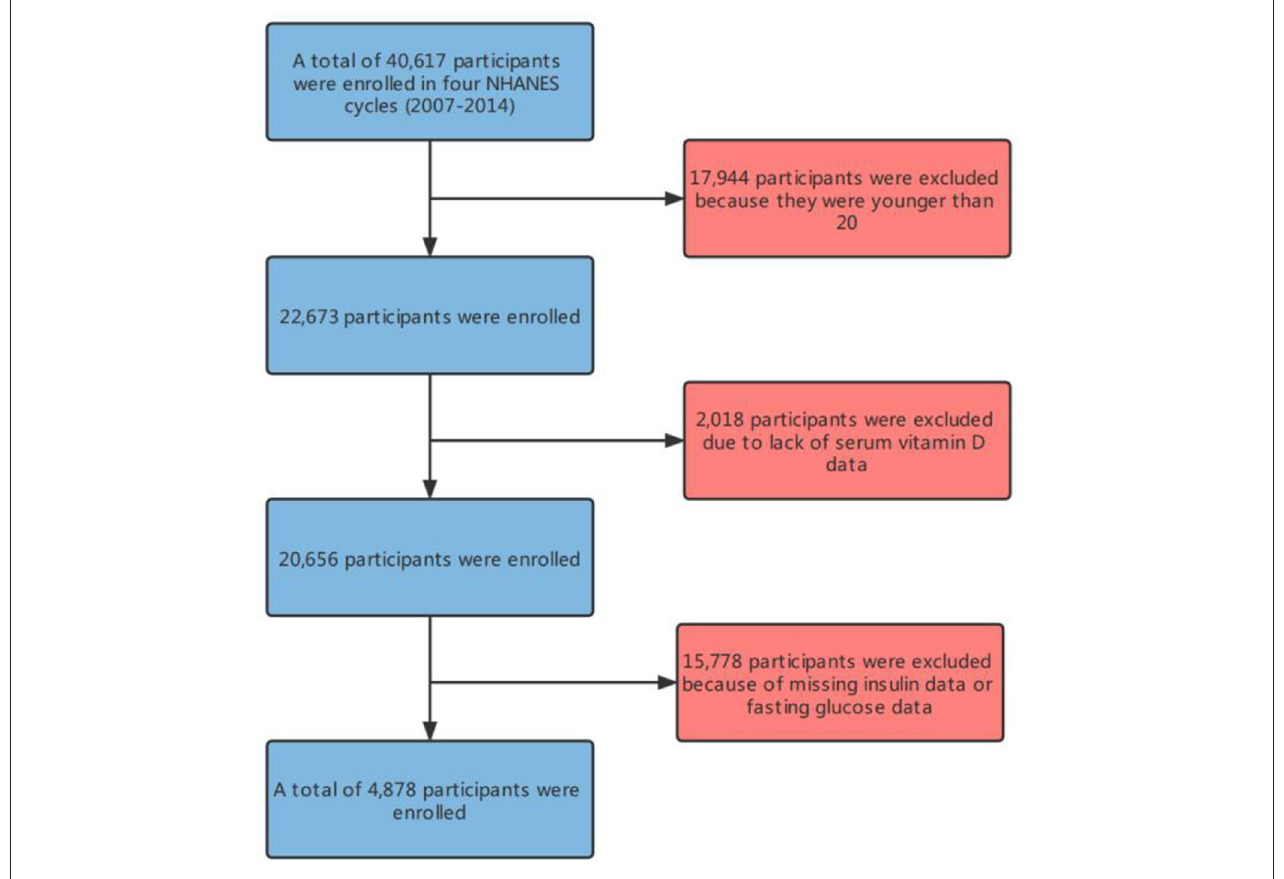
FIGURE 1 | Flowchart of participant